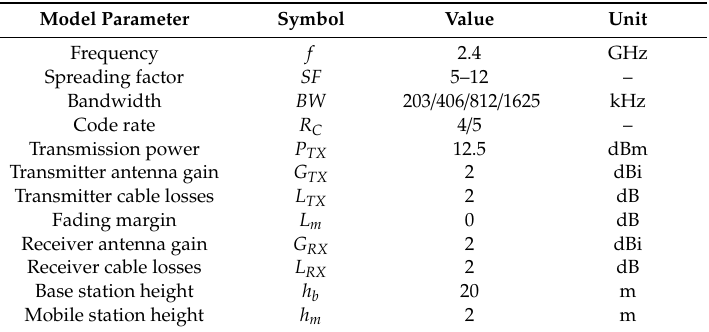
Table 1. Parameters used for path loss